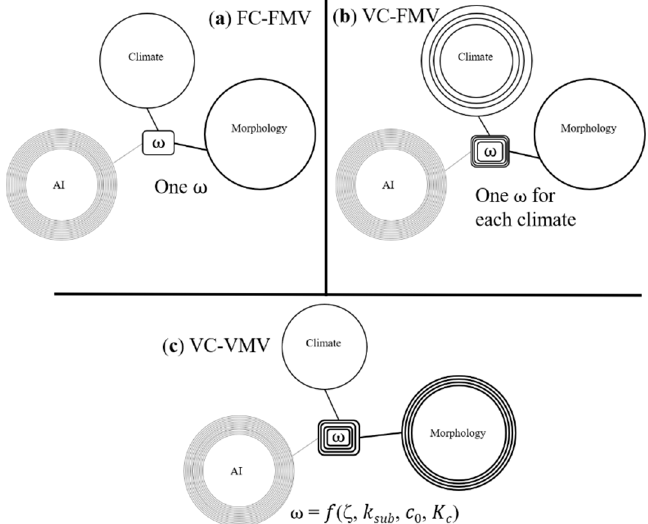
Figure 1. ( a ) Fixed climate, fixed morphology and vegetation: given a climate, a watershed, over different annual precipitation, and potential evapotranspiration, hydrological response follows the same law. ( b ) Varying climate, fixed morphology and vegetation: given a watershed, the climate drives the hydrological response in different ways. ( c ) Varying climate, varying morphology and vegetation: for each climate, the water partitioning process is driven by morphological and vegetation properties of the basin.